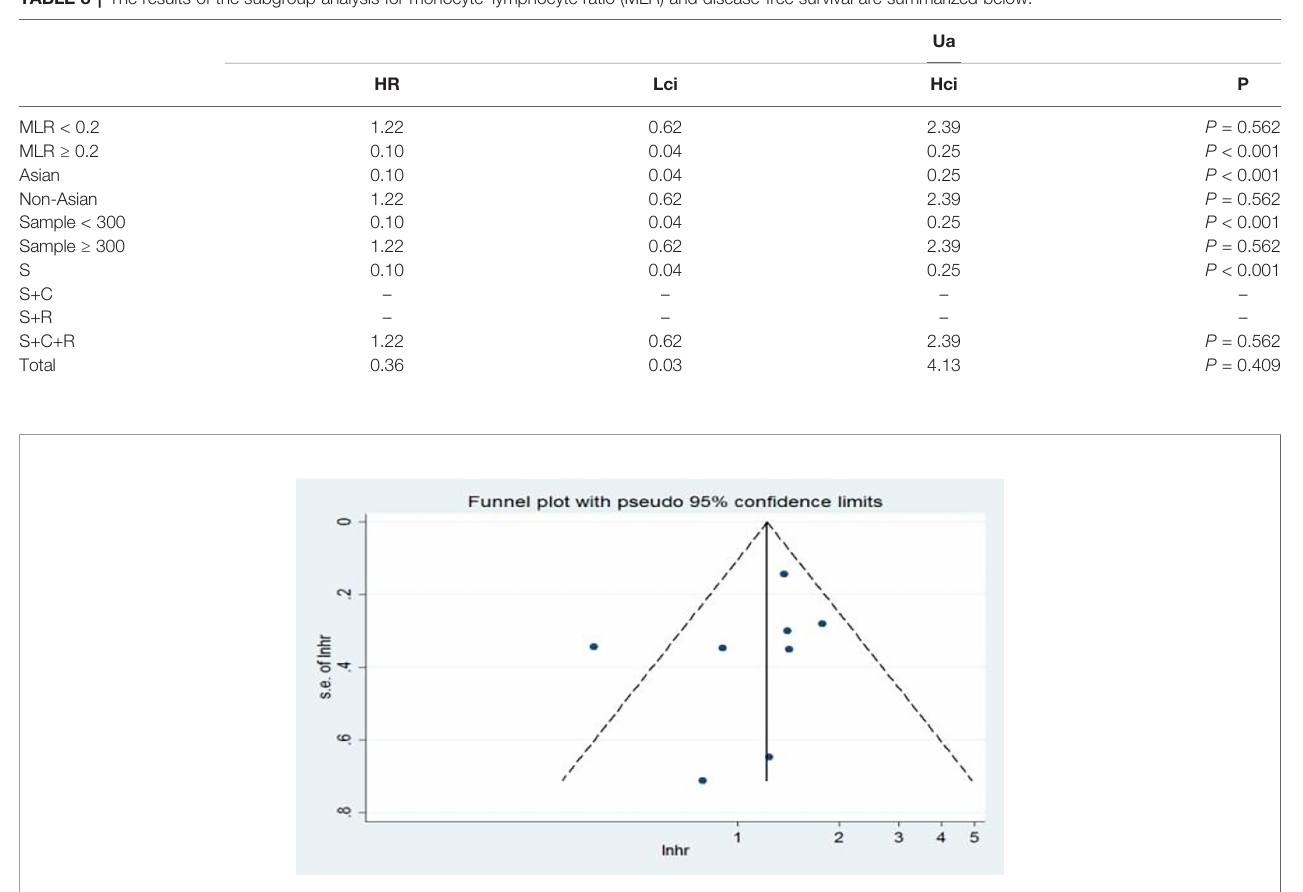
FIGURE 9 | Funnel plots of the relationship between neutrophil – lymphocyte ratio and overall survival in univariate